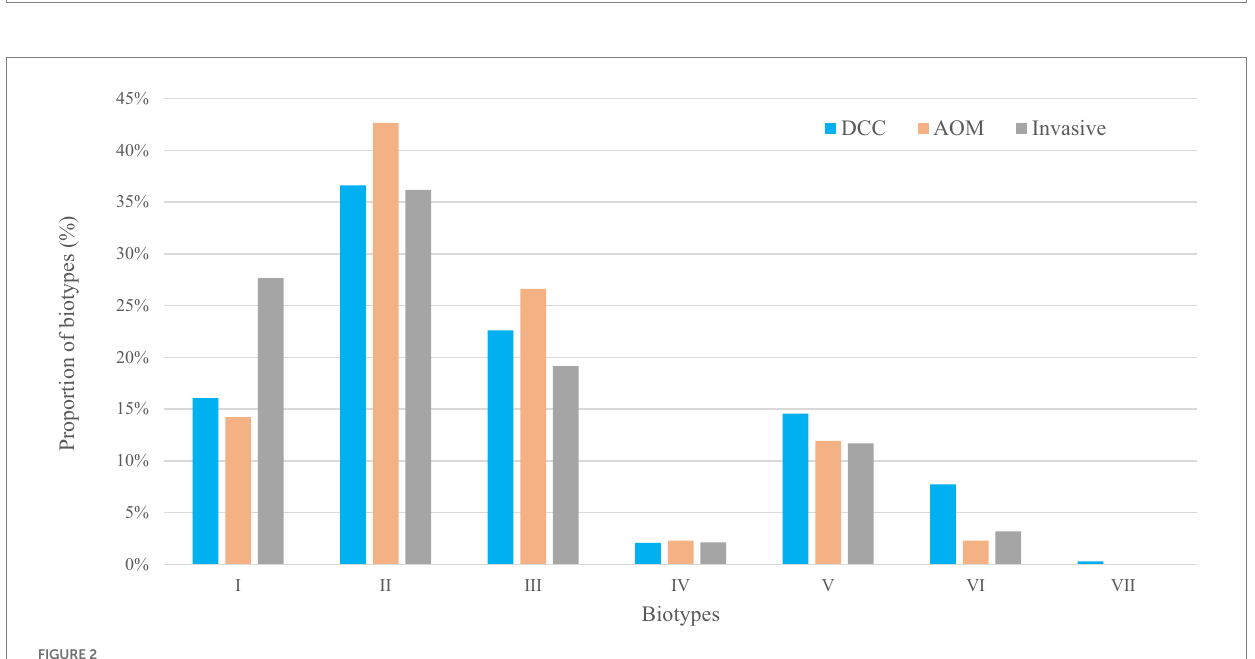
FIGURE 2 Biotypes of Haemophilus influenzae in the carriage (AOM and DCC) and invasive group. Overall proportions of circulating biotypes in the carriage groups AOM (in orange) and DCC (in blue) as well as in the invasive group (in grey) detected in strains collected during the period 2016–2018 for the carriage group and 2015–2018 for the invasive